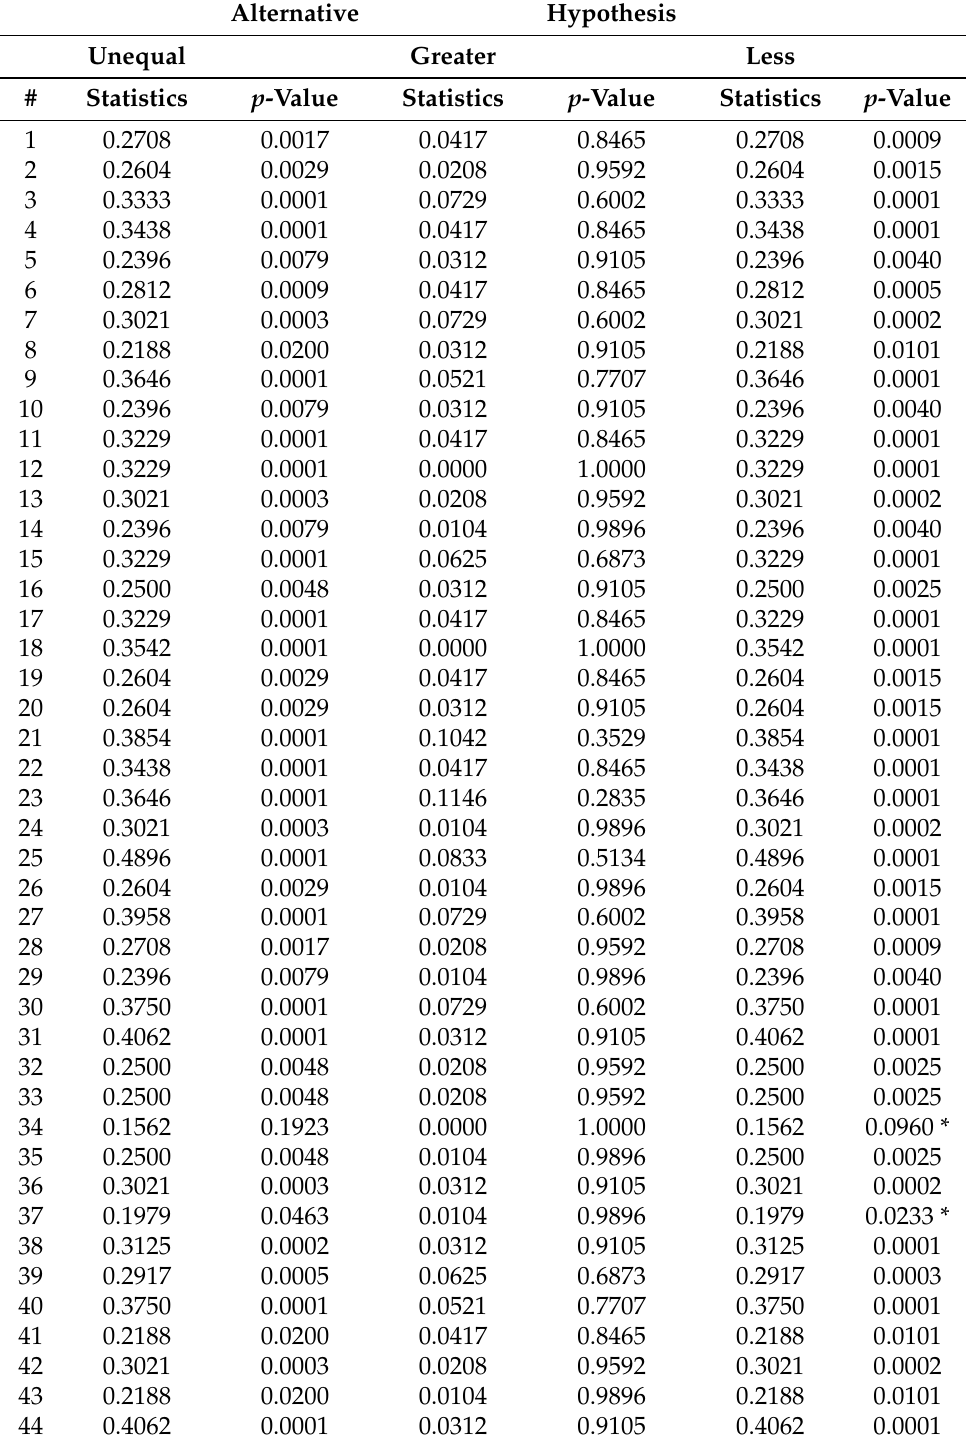
Table 3. Two-sample Kolmogorov–Smirnov test results for the Single SSRT distribution versus Mixture posterior SSRT distribution ( n =